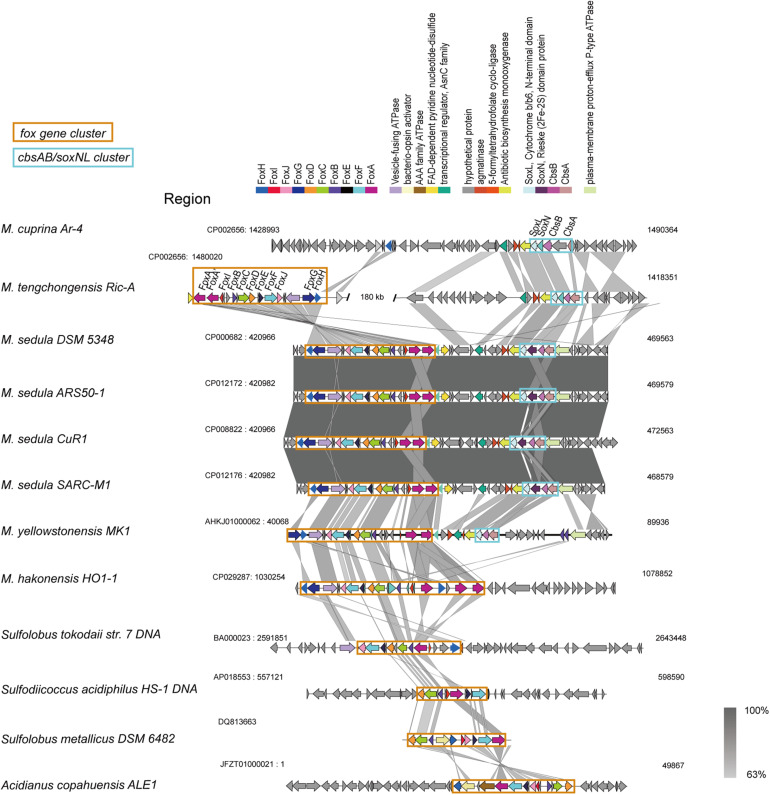
Synteny analysis of fox gene clusters and soxNL/cbsAB gene clusters derived from representative Metallosphaera strains and other representative species in Sulfolobales.